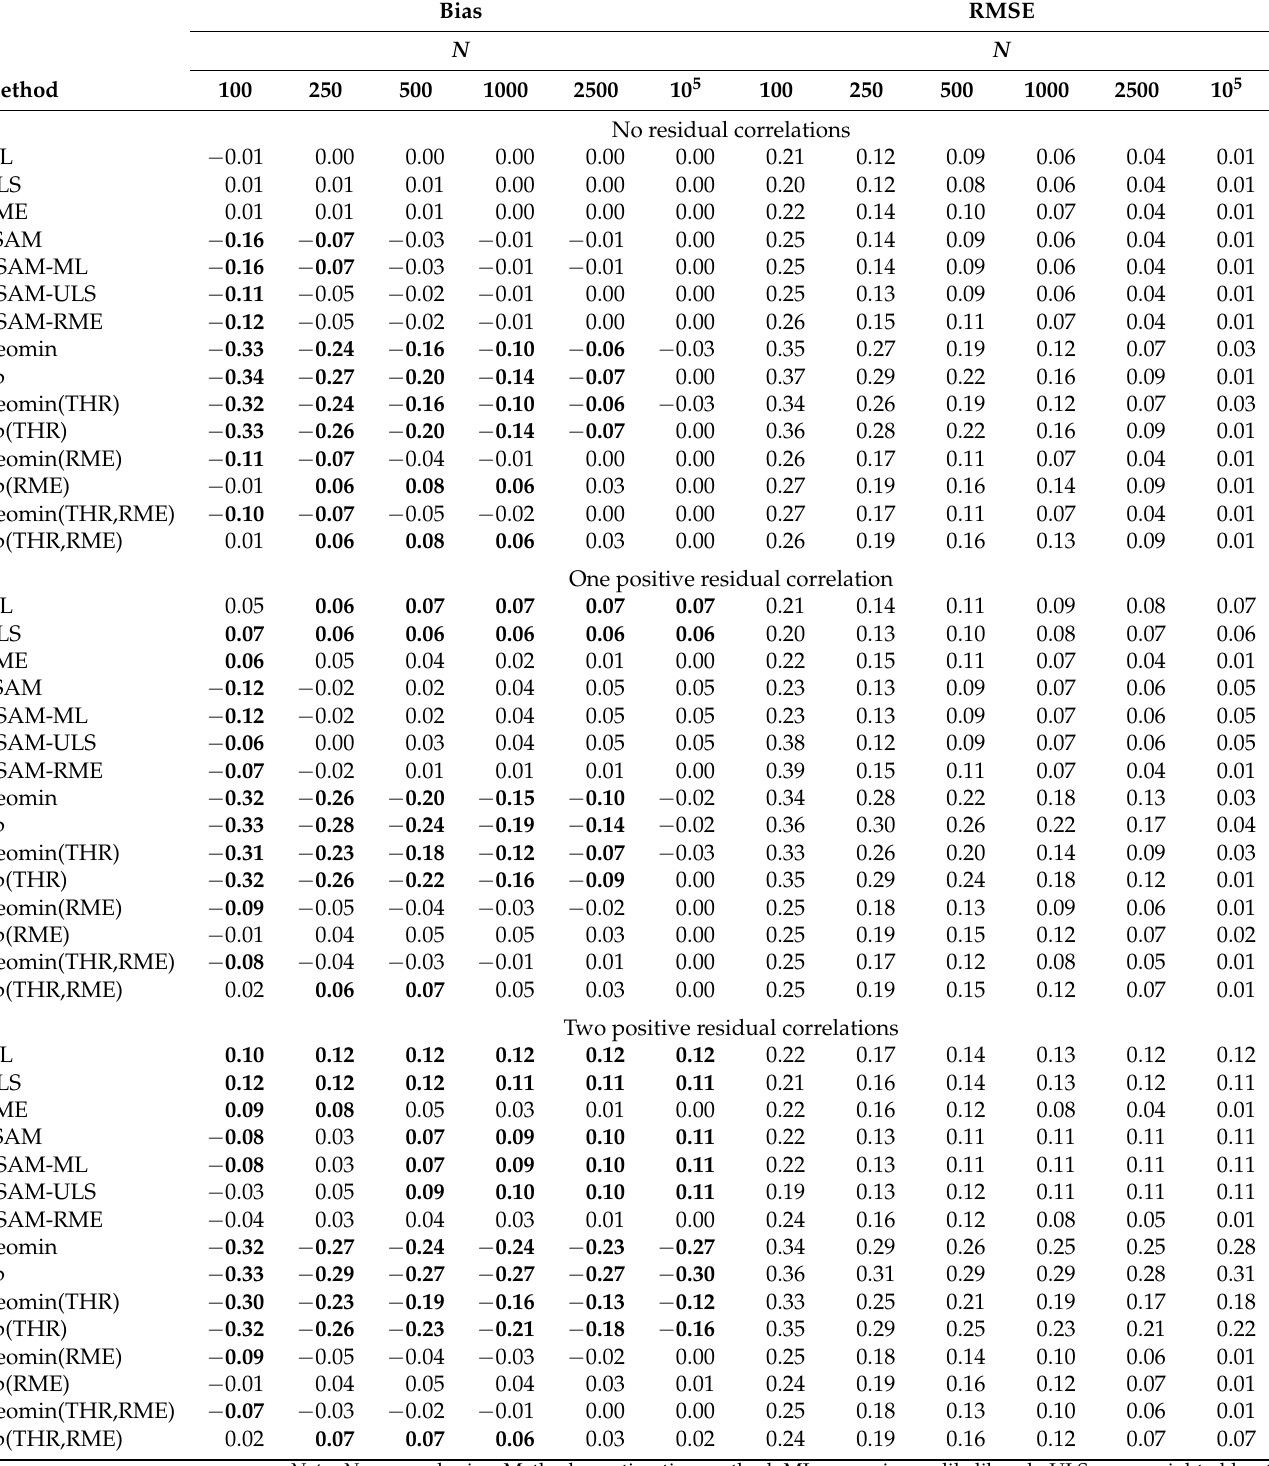
Table 1. Simulation Study 1 (two factors and residual correlations): bias and root mean square error (RMSE) of estimated factor correlation as a function of sample size with no, one positive, and two positive residual correlations in the data-generating